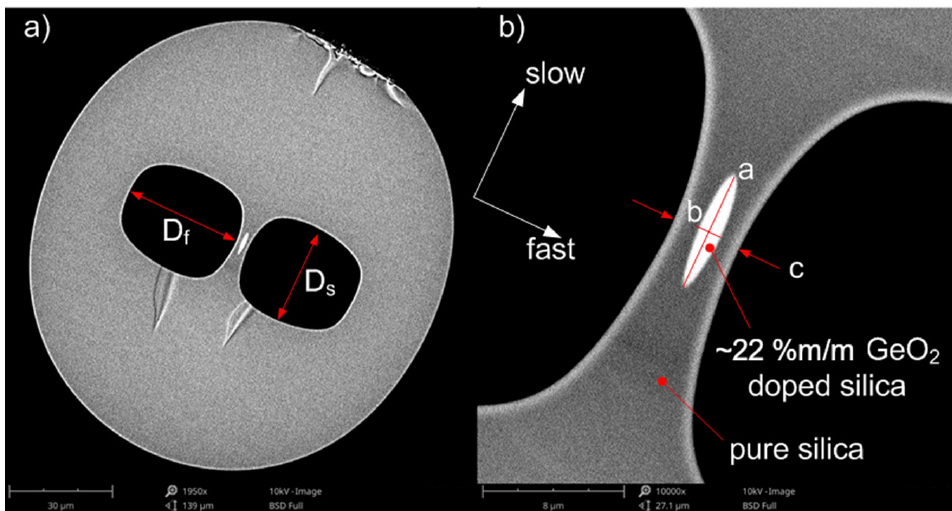
Figure 1. SEM images of SH2 cross-section: ( a ) entire optical fiber, ( b ) zoomed glass bridge with highly GeO 2 -doped silica elliptical core. The coordinate system (white arrows) indicates the slow and fast axes of the SH fiber. The letters a, b and c indicate long a and short b diameters of the core ellipse and glass bridge thickness c , respectively. Table 1. Geometrical parameters of SH fibers.